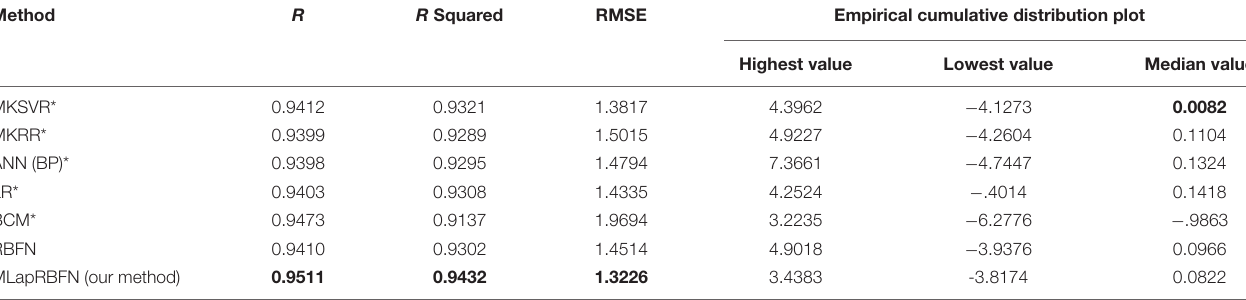
TABLE 2 | Comparison with other methods